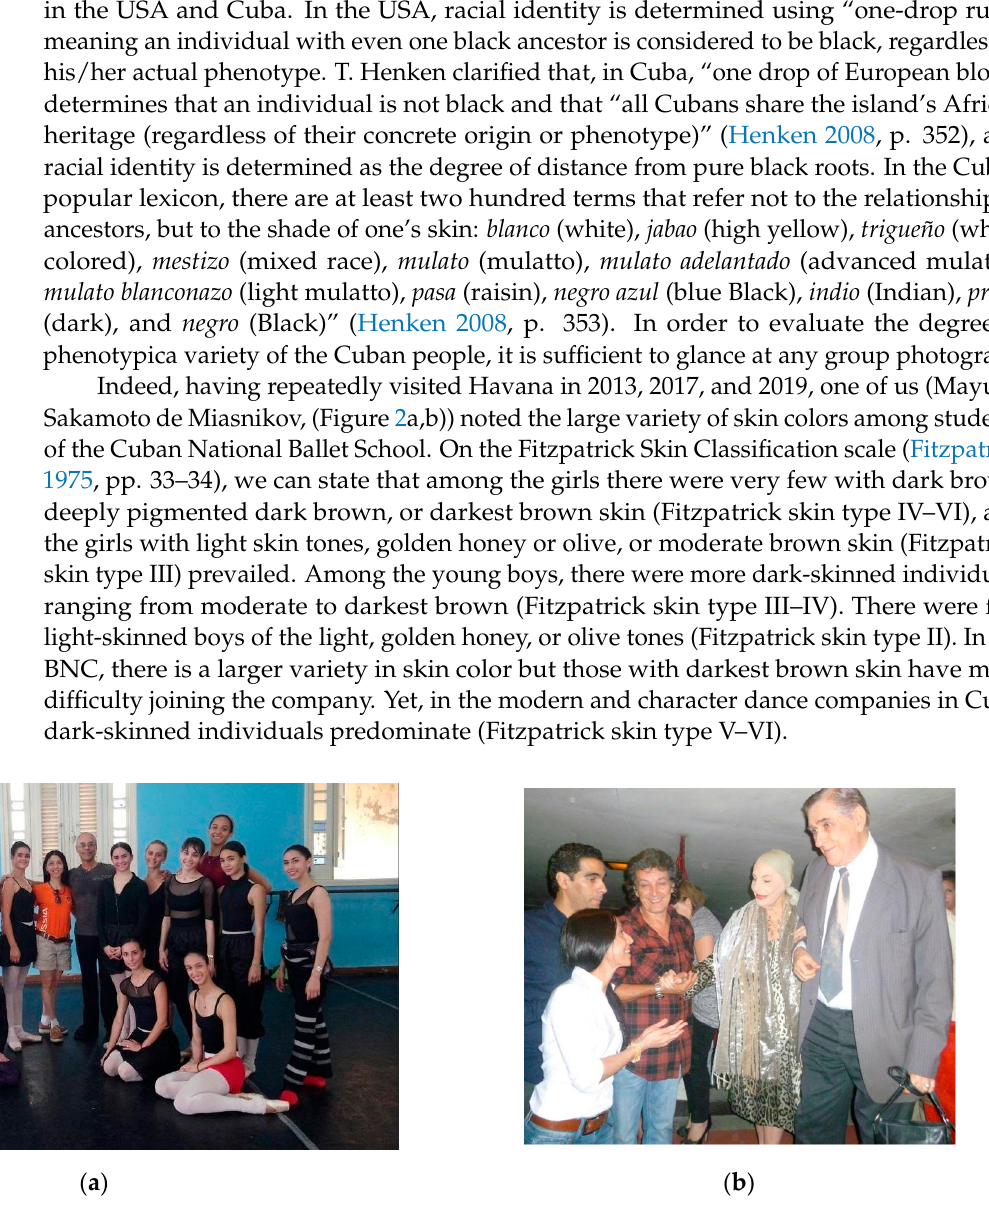
Figure 2. ( a ) Mayumi Sakamoto de Miasnikov with Maestro Lazaro Carreño and artists of the National Ballet of Cuba in the rehearsal hall. 2019; ( b ) Alicia Alonso, Pedro Simon (historiographer of the Cuban National Ballet, director of the Museum of Dance, editor-in-chief of Cuba in Ballet journal, and husband of the great ballerina), Félix Rodríguez (soloist, teacher-rehearser of the National Ballet of Cuba). 2013. From the personal archive of Mayumi Sakamoto de Miasnikov . Hamlet Betancourt León believes that “social discrimination” exists in Cuban ballet.